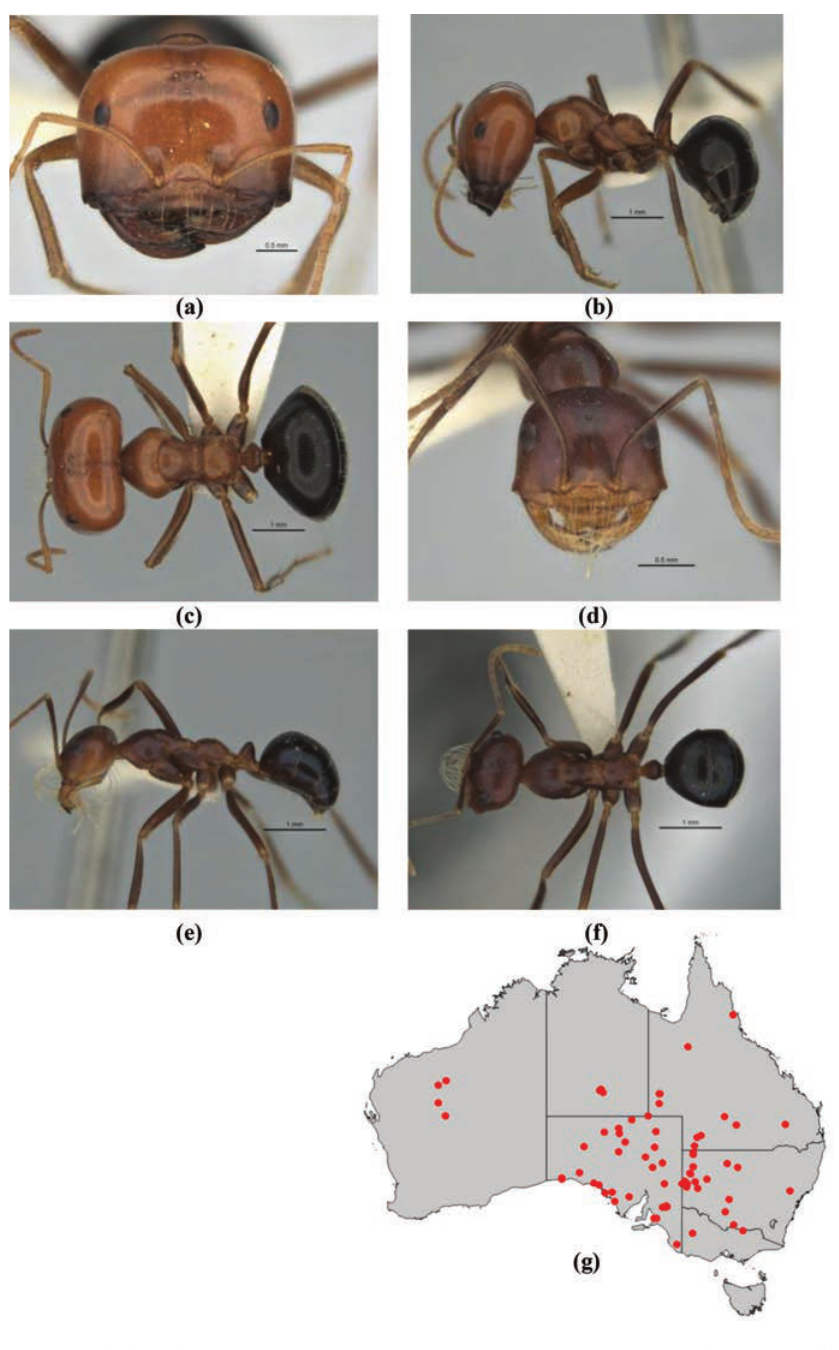
Figure 82. Melophorus laticeps Wheeler: no n–t ype major worker (ANIC32-900188) frons ( a ), profile ( b ) and dorsum ( c ); non–type minor worker (ANIC32-900187) frons ( d ), profile ( e ) and dorsum ( f ); distribu- tion map for the species ( g ). Low resolution scale bars: 1 mm ( b, c , e, f ); 0.5 mm ( a, d